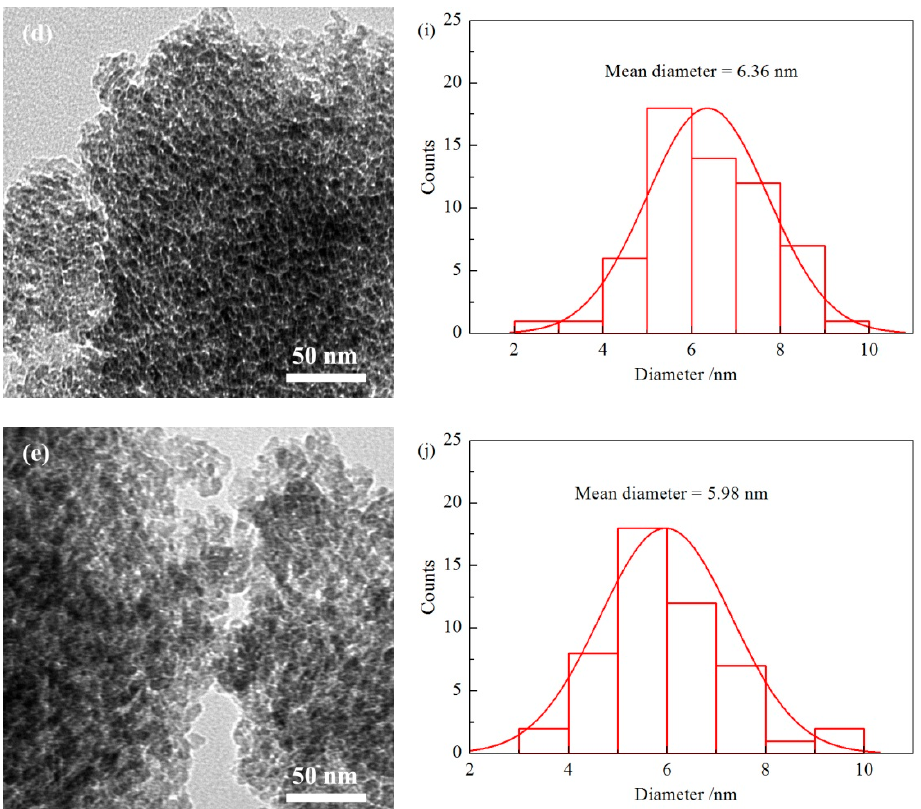
Figure 5. Transmission electron microscopy (TEM) images and particle distribution of bimetallic Ni x Cu (10- x ) / γ -Al 2 O 3 catalysts. ( a , f ) Ni/ γ -Al 2 O 3 ; ( b , g ) Ni 7 Cu 3 / γ -Al 2 O 3 ; ( c , h ) Ni 5 Cu 5 / γ -Al 2 O 3 ; ( d , i ) Ni 3 Cu 7 / γ -Al 2 O 3 ; ( e , j ) Cu/ γ -Al 2 O 3.